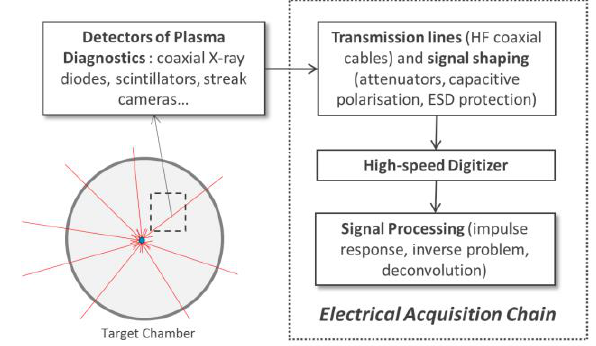
Fig. 1. Synoptic of a diagnostic acquisition chain at